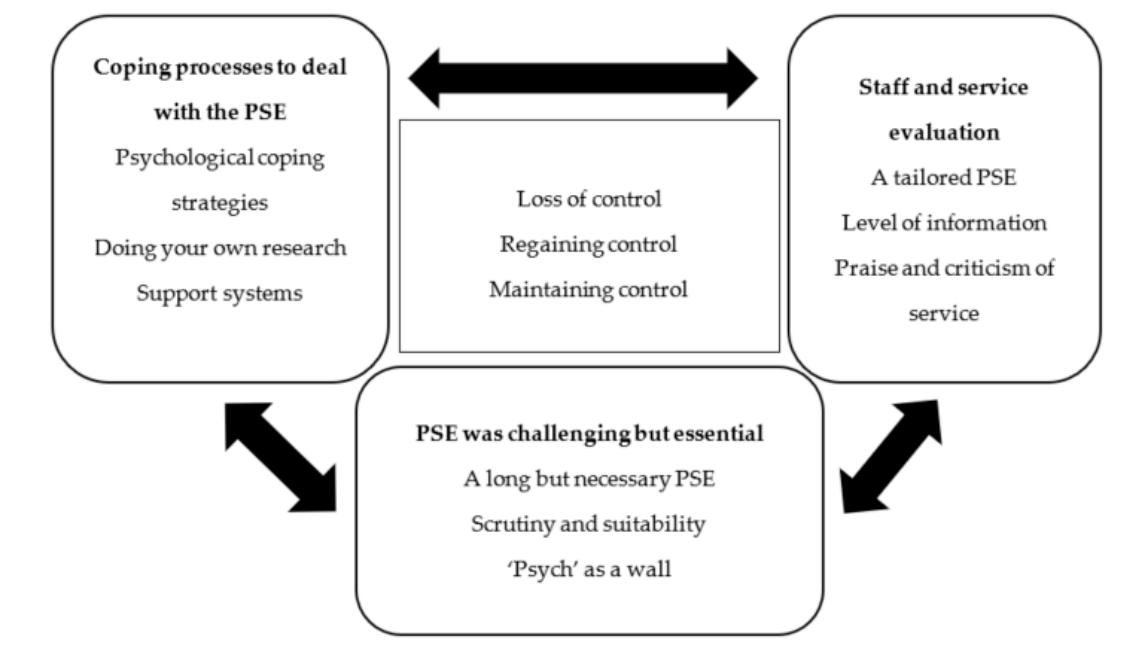
Figure 1. Visual representation of the themes.